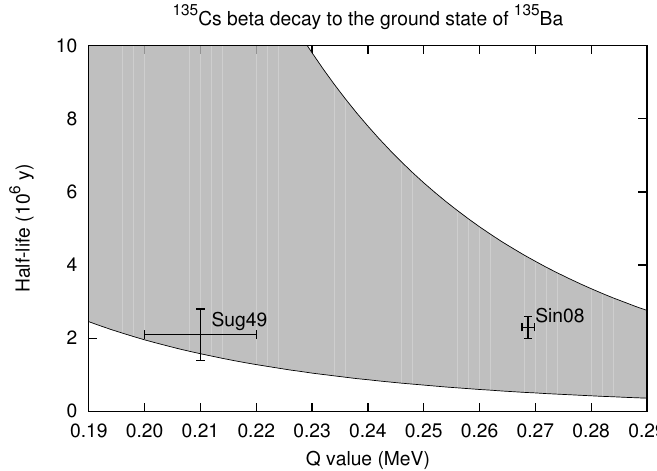
Figure 3. Computed β − -decay half-life as a function of the decay Q value for the transition from 135 Cs to the ground state of 135 Ba for the range g A = 1 . 00 − 1 . 25 (shaded area). Two experimental half-life and Q -value measurements [17, 18] are also